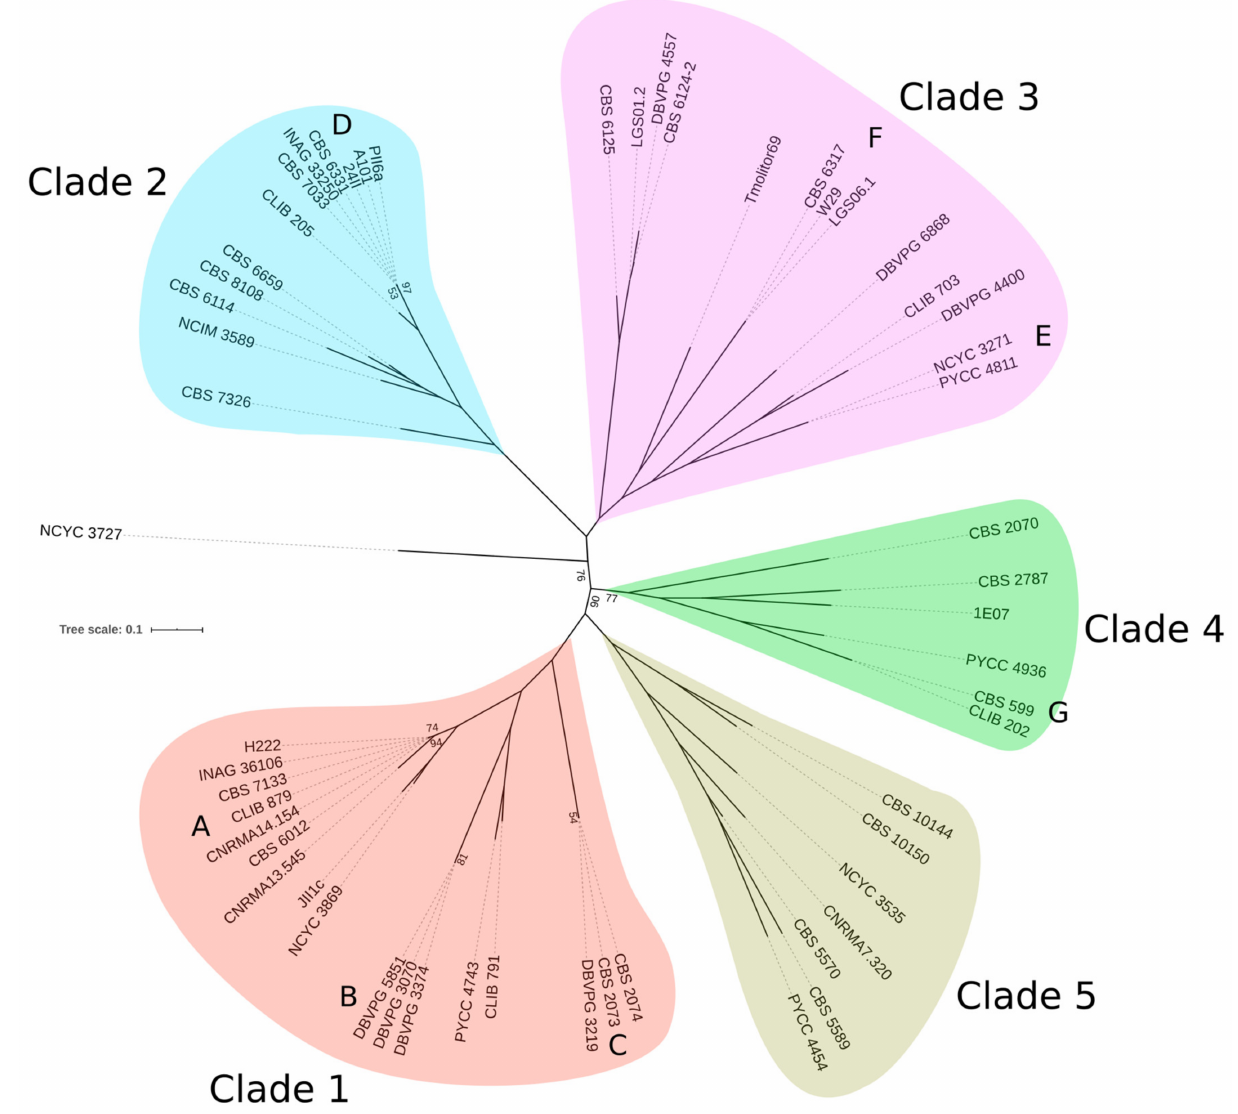
Figure 1. Maximum likelihood phylogenetic tree obtained from 133,528 biallelic SNPs present in at least two strains using RAxML (evolution model: GTRGAMMA). Only bootstrap values under 100 are